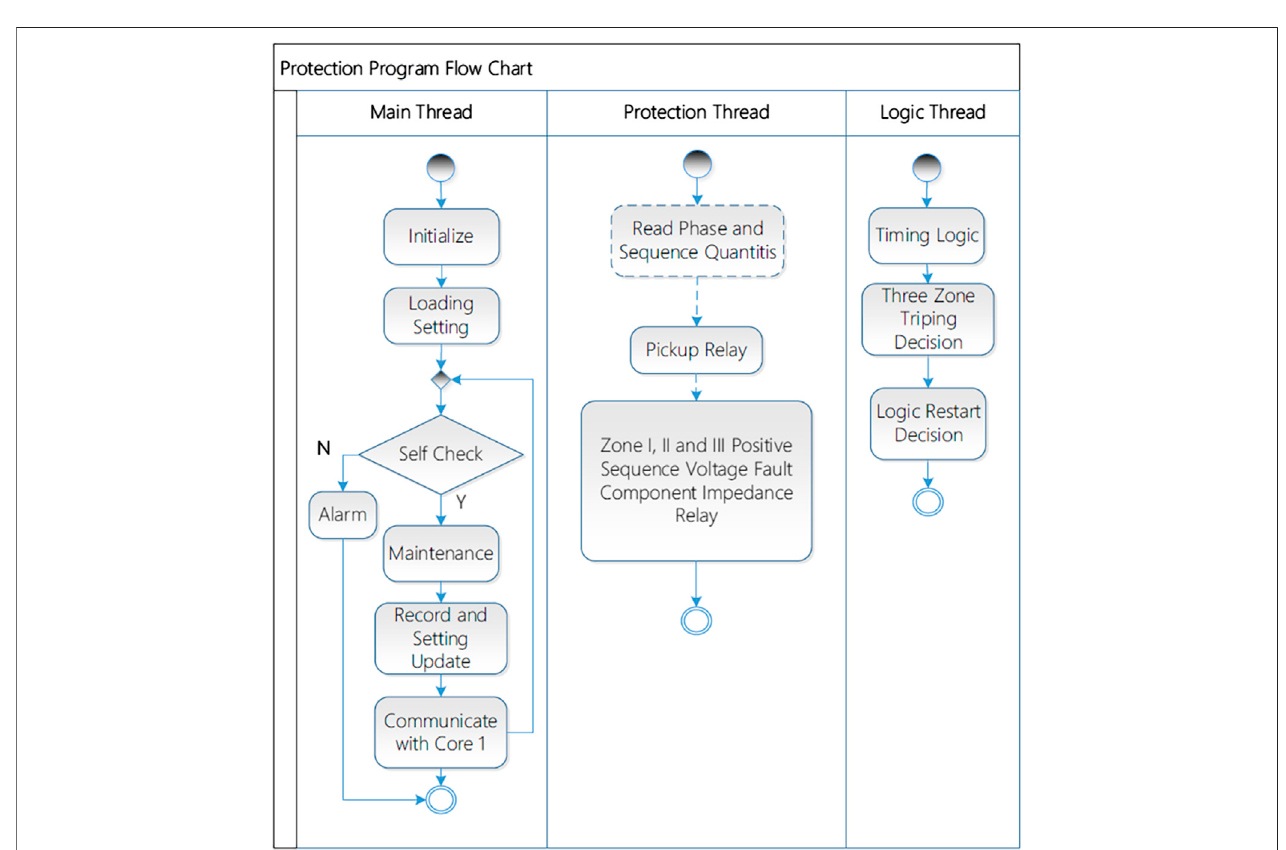
Frontiers in Energy Research |